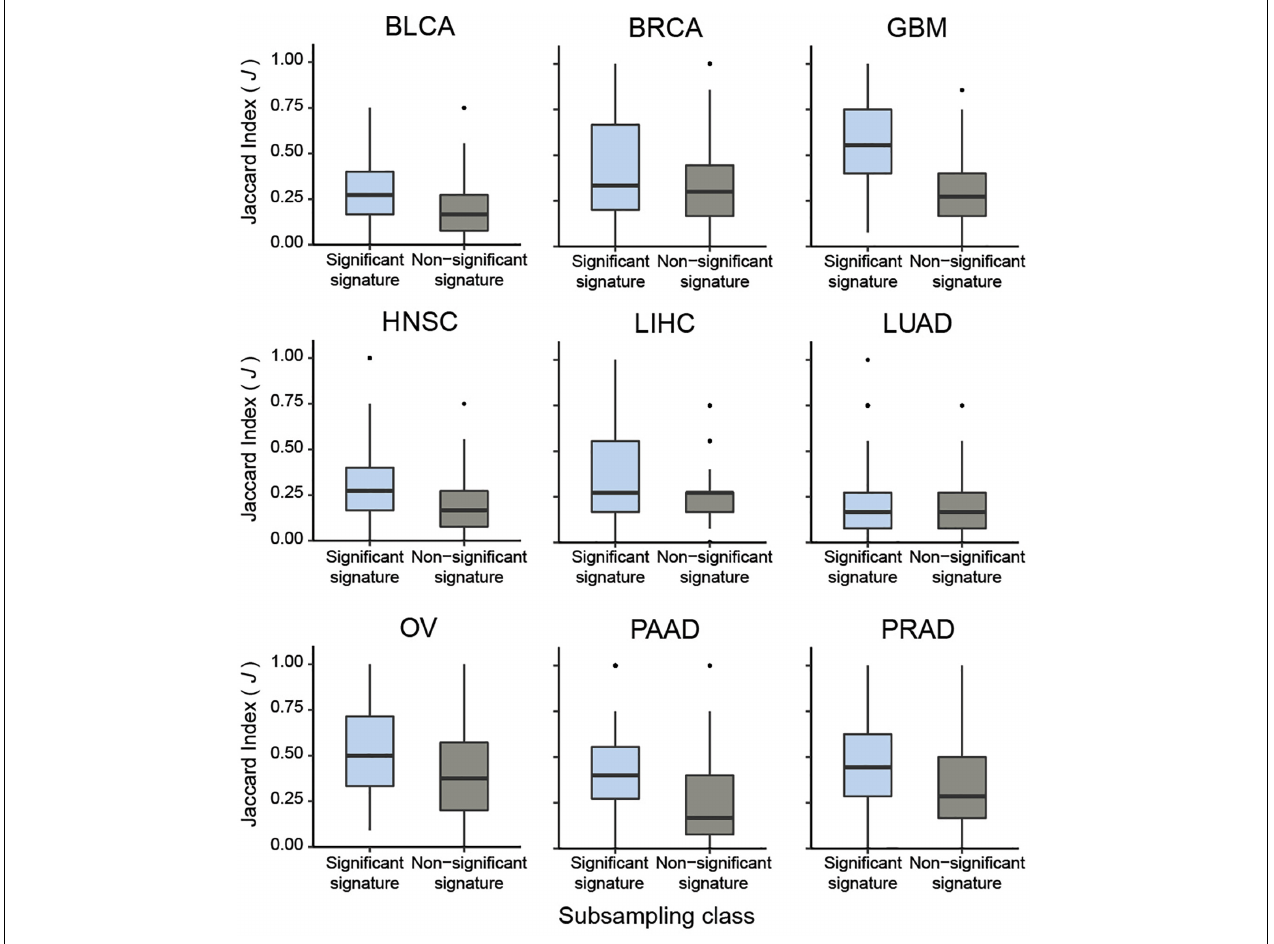
FIGURE 6 | Pan-cancer sub-sampling analysis confirms agreement between CaDrA search significance and reproducibility of identified meta-features. CaDrA was applied to search for genomic alterations associated with elevated protein expression for all proteins profiled using RPPAs, for nine different cancer types in TCGA. Reproducibility by sub-sampling was then assessed for the top 5 significant (CaDrA P ≤ 0.05), and 5 non-significant (CaDrA P > 0.05) protein queries (see text). Consistency of CaDrA results was computed by the Jaccard ( J ) index of the returned meta-feature obtained with and without sub-sampling for each iteration, with the J indices pooled for the 5 significant and non-significant results, respectively. Box plots highlight a significantly higher J index coefficient among the significant protein queries compared to the non-significant queries across all cancer types investigated (Wilcox FDR <